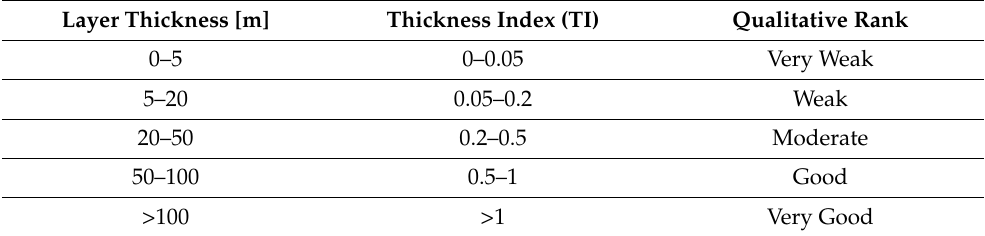
Table A3. Geomechanical units based on Thickness Index